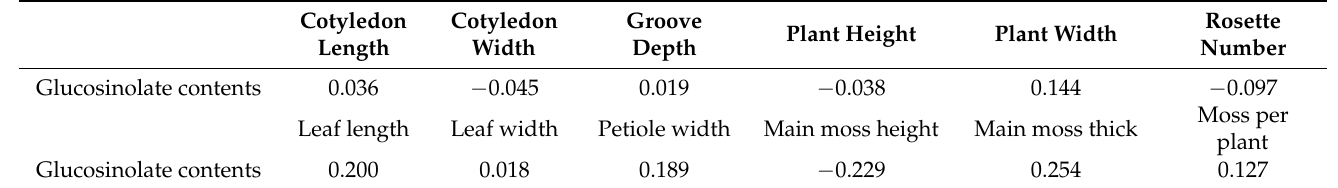
Table 6. Correlation between quantitative traits and glucosinolate contents in 60 mustard resources.